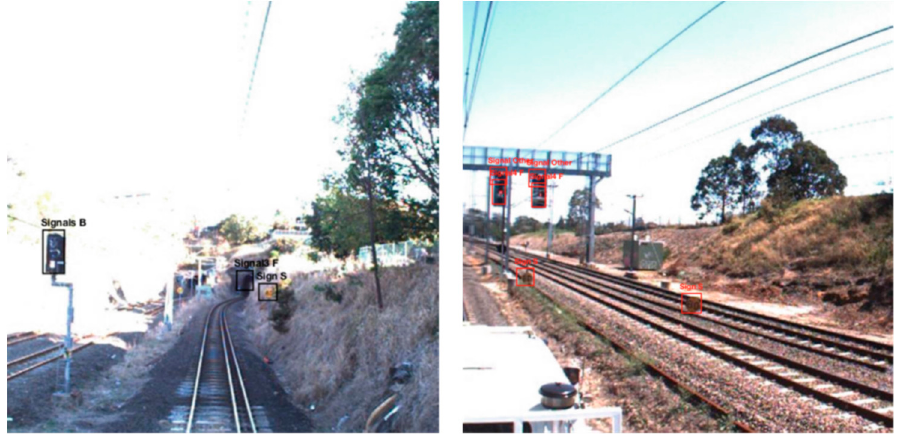
Figure 11. Signalization. Karagiannis et al. [163] implemented a R-CNN for sign detection using RGB images.